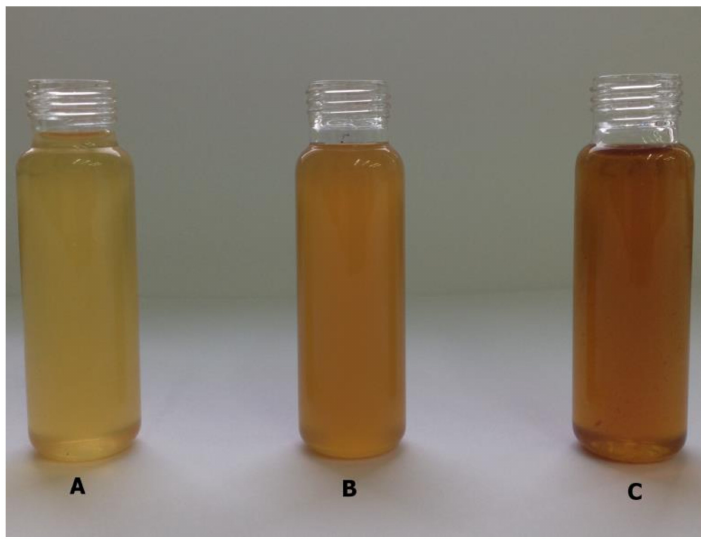
Figure 1. Color of sweet mash samples ( A –sample no. 29; B –sample no. 22; C –sample no. 34).